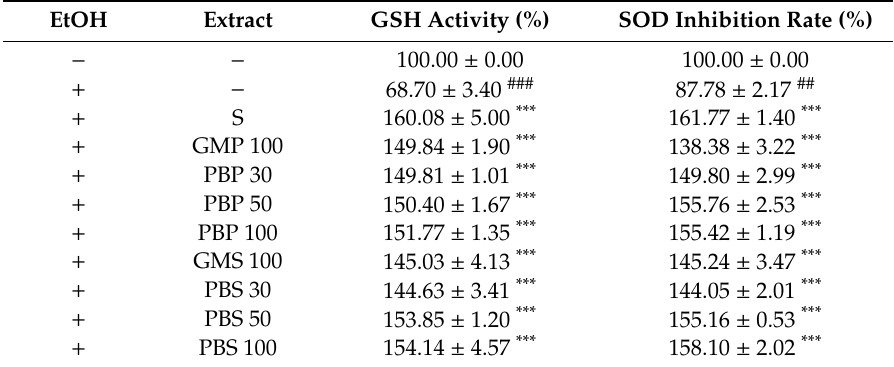
Table 3. Antioxidant potential of the paste and sauce made from PBL koji. The GSH activity was analyzed after 300 mM EtOH treatment on HepG2 cells pretreated with 95% EtOH extract of each paste and sauce. The SOD inhibition rate was investigated after 300 mM EtOH treatment on HepG2 cells pretreated with 95% EtOH extract of each paste and sauce. EtOH Extract GSH Activity (%) SOD Inhibition Rate (%) − − 100.00 ± 0.00 100.00 ± 0.00 + − 68.70 ± 3.40 ### 87.78 ± 2.17 ## + S 160.08 ± 5.00 *** 161.77 ± 1.40 *** + GMP 100 149.84 ± 1.90 *** 138.38 ± 3.22 *** + PBP 30 149.81 ± 1.01 *** 149.80 ± 2.99 *** + PBP 50 150.40 ± 1.67 *** 155.76 ± 2.53 *** + PBP 100 151.77 ± 1.35 *** 155.42 ± 1.19 *** + GMS 100 145.03 ± 4.13 *** 145.24 ± 3.47 *** + PBS 30 144.63 ± 3.41 *** 144.05 ± 2.01 *** + PBS 50 153.85 ± 1.20 *** 155.16 ± 0.53 *** + PBS 100 154.14 ± 4.57 *** 158.10 ± 2.02